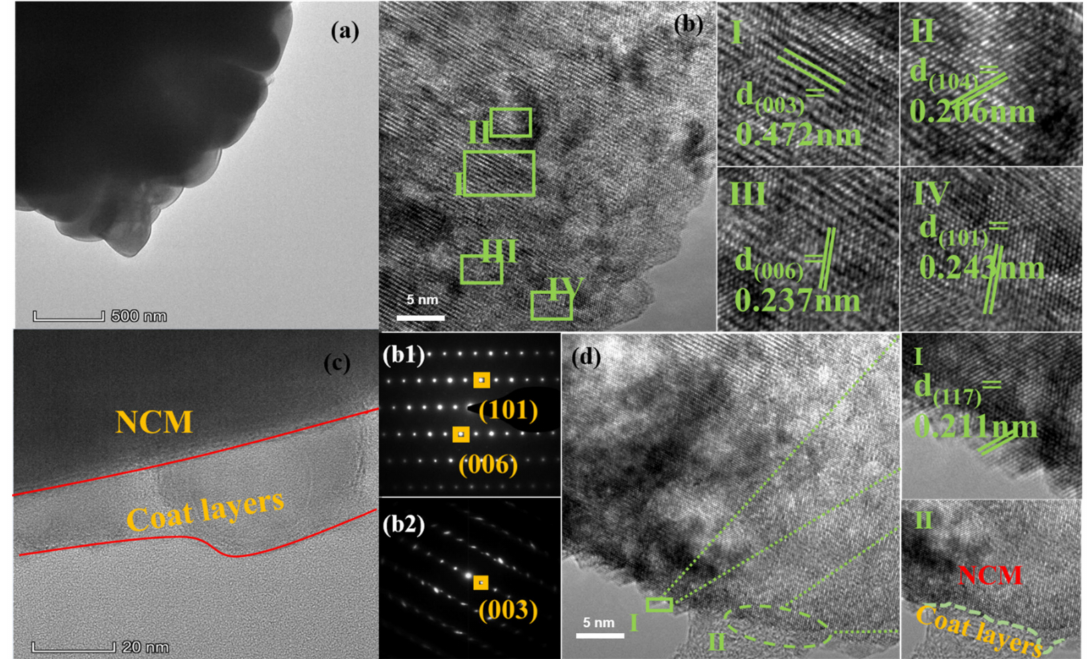
Figure 3. ( a ) TEM images of as-prepared NCM811 cathodes and the corresponding HRTEM images of NCM811 shown as ( I – IV ). ( b , c ) show the fast Fourier transform (FFT) patterns of NCM811. ( d ) TEM images of NCM811@ALP500 and the corresponding HRTEM images, shown as ( I , II ). ( b1 ) is area ( IV ); ( b2 ) is area ( I ).